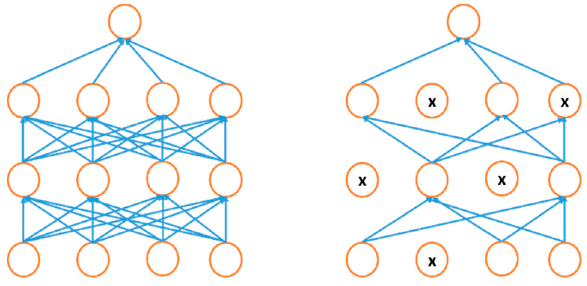
Figure 27. Pictorial representation of the concept Dropout.